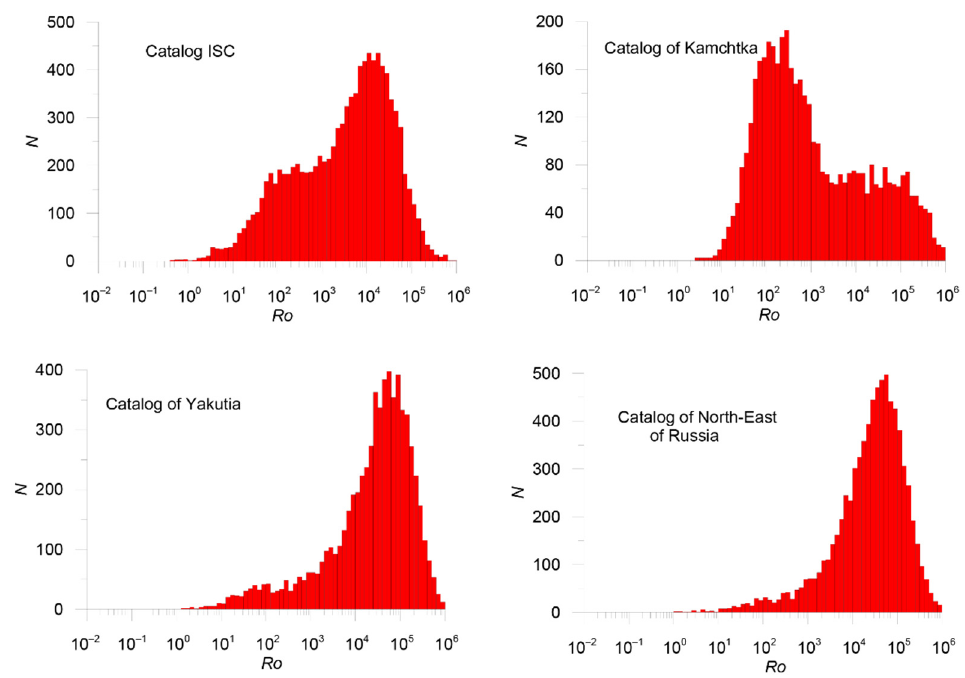
Figure 2. Distribution of metric (1) for events within the source catalogs (Tables 1 and 2). The catalogs are indicated on the